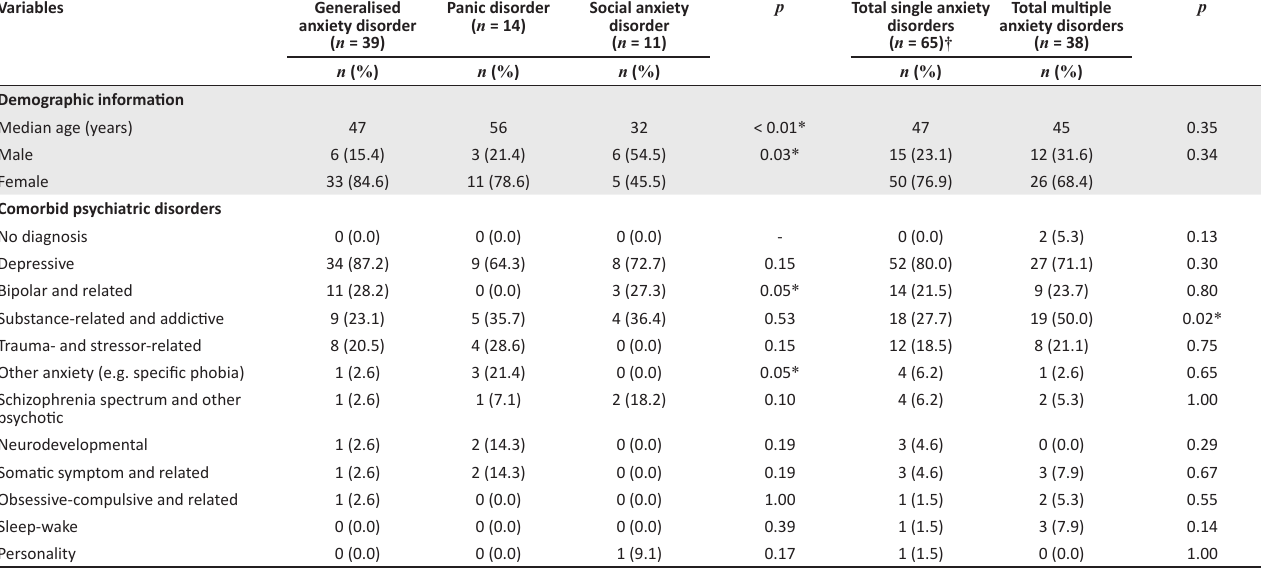
TABLE 3: Age, gender and diagnostic comorbidities of patients with single anxiety diagnosis or multiple anxiety diagnoses. Variables